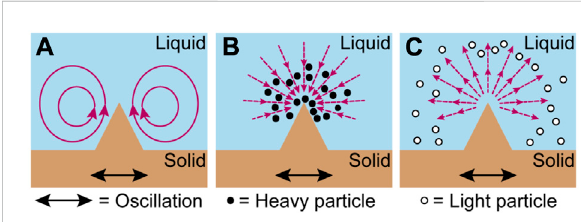
FIGURE 1 Illustration of the main phenomena driven by the oscillations of a sharpedgerelativetothesurrounding fl uid: (A) thesharp-edge-driven acoustic streaming [4], (B) the attraction of “ heavy ” particles to the tip of the sharp edge due to the ARF [7], and (C) the ARF-based repulsion of “ light ” particles by the sharp edge